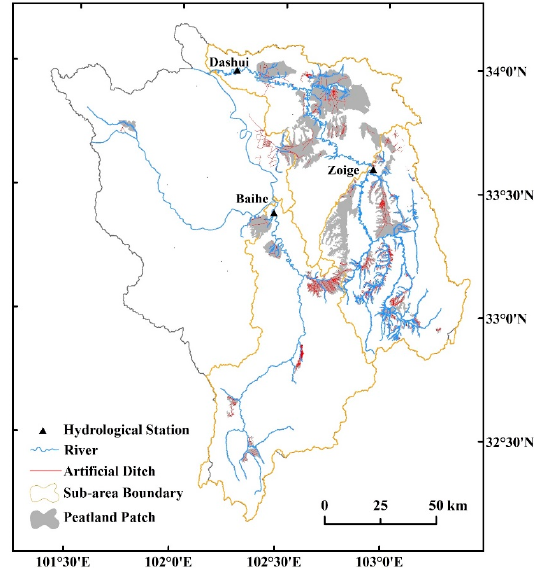
Figure 2. Spatial patterns of the clustered artificial ditches in the associated peatland patches and three zones (Dashui, Zoige, and Baihe) in which rainfall water drains to the locations where the three hydrological stations are located. Each peatland patch was connected through ditches to natural gullies, tributaries, and the main river stems (Note: a few ditches located in grasslands were not included).